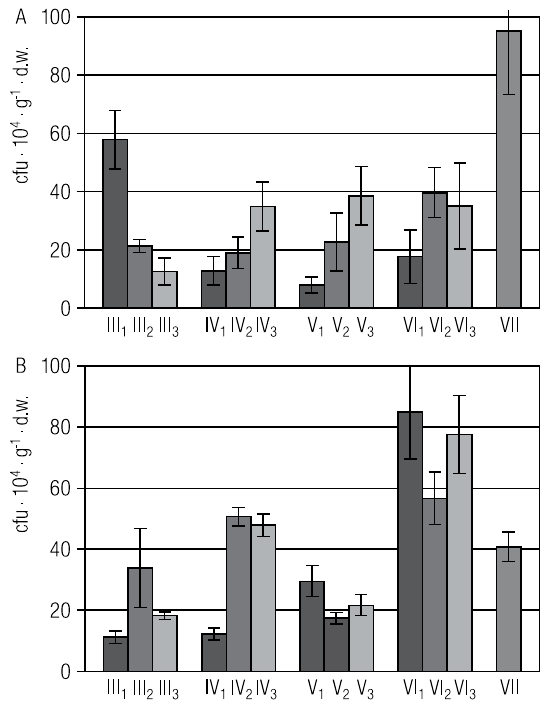
Fig. 1. The preavalence rate of fungi in the nests of Montagu’s Harrier (cfu . 10 4 . g -1 d.w.): a – on the waksman’s medium for cellu- lolytic fungi, B – on the substrate for the genus